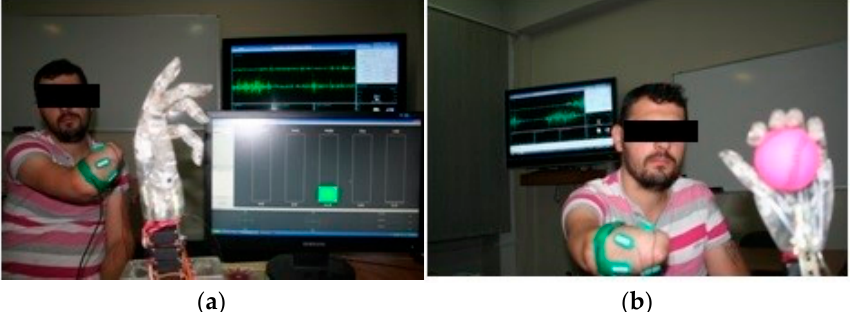
Figure 2. Testing the amputee patient with the myoelectric hand: ( a ) The myoelectric hand in resting position; ( b ) The myoelectric hand during an active movement, connected to the sEMG receiver.